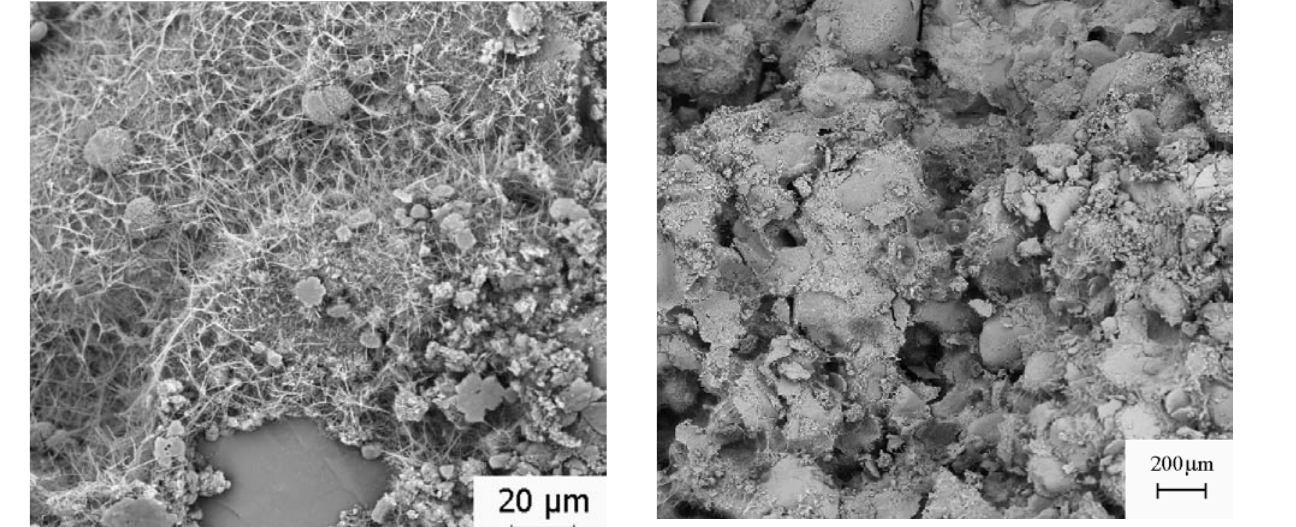
Figure 11. SEM micrograph of the aggregate partially covered by bottom ash powder in the (J) samples (CPI-S-32 cement/5% bottom ash/sand) after 28 days of